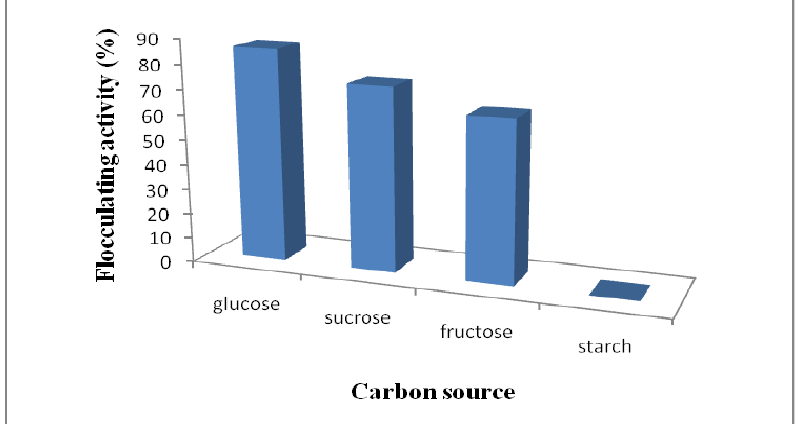
Figure 3. Effect of carbon source on flocculating activity of Halomonas sp. OKOH